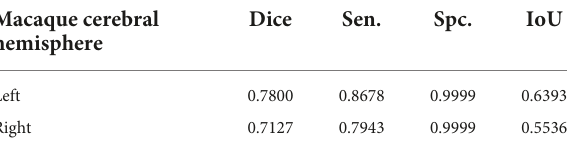
TABLE 4 Indication of CS and MD in anatomical connectivity fingerprints between human and